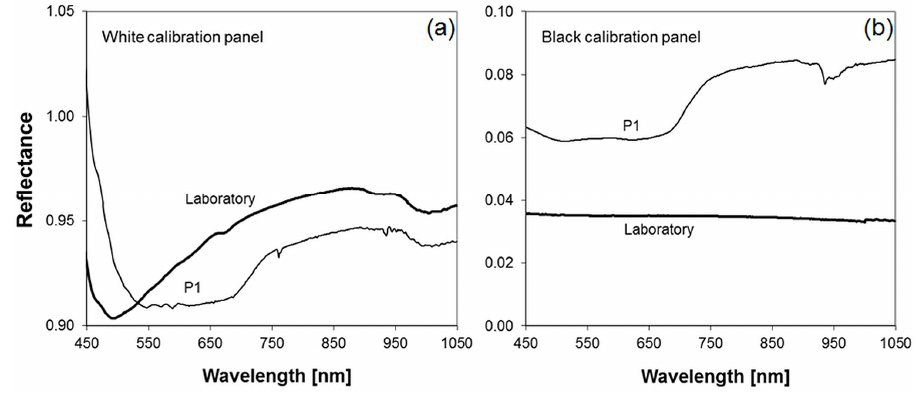
Figure 10. ( a ) Reflectance of the white calibration panel (matt white Bristol cardboard) from laboratory and field measurements at P1; ( b ) Reflectance of the black calibration panel (black cardboard) from laboratory and field measurements at